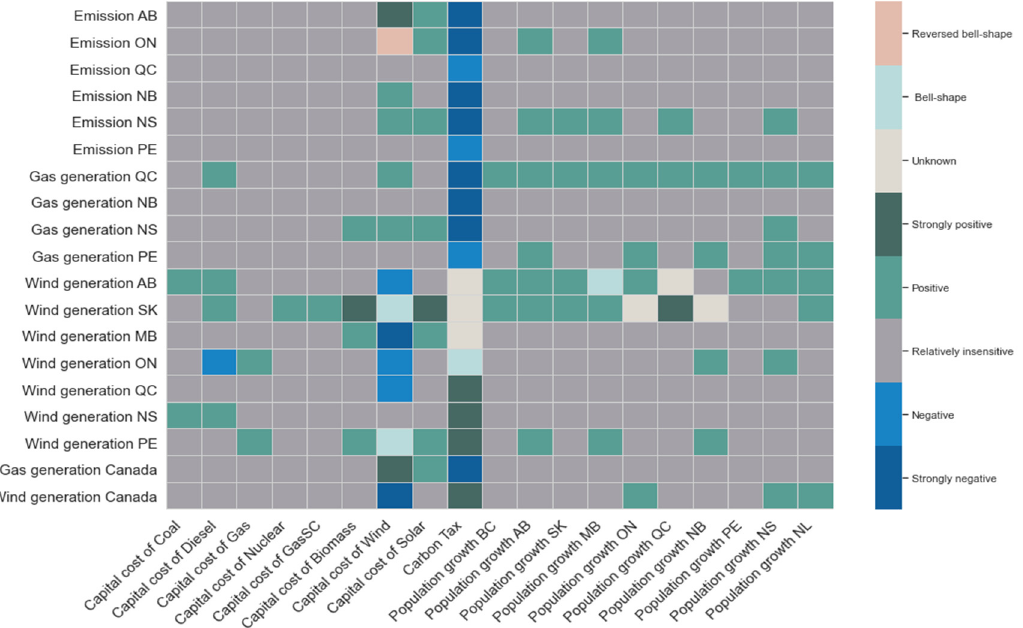
Figure 5. This heat map shows the relationship between the inputs ( x -axis) and outputs ( y -axis) in 2050. It includes only design variables that have variations in the training dataset. The correlations are color-coded based on the shape of input-output correlation plots. The plots are scaled for each output based on the minimum and maximum values, so the relationships depicted in the heat map are relative to the specific output being considered. The heat map provides a visual representation of how each input affects each output and allows for easy identification of the strongest relationships.